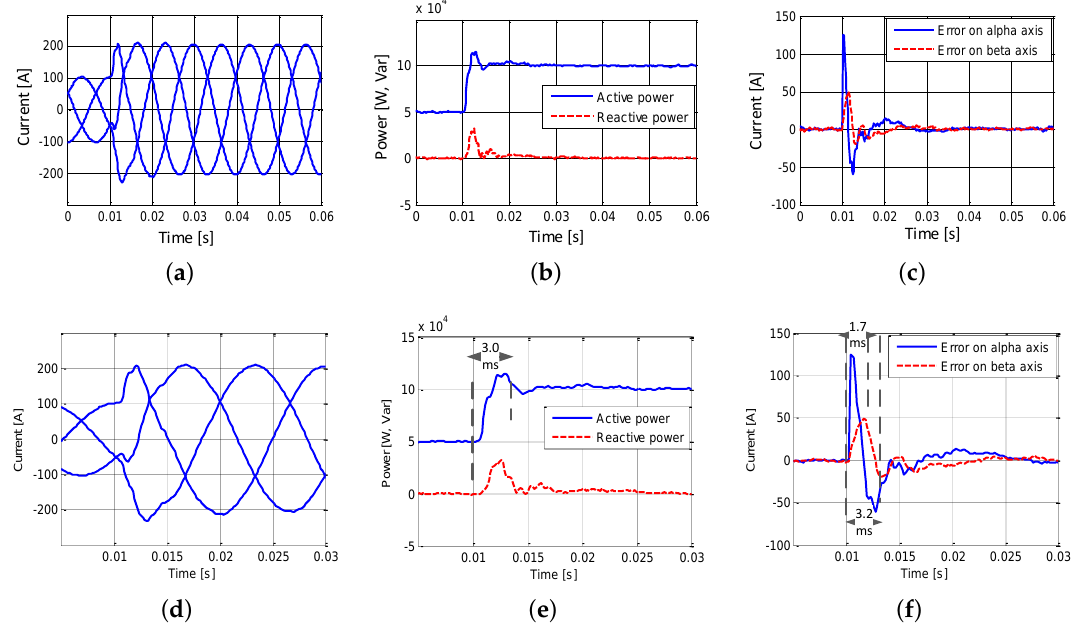
Figure 10. Simulated performance of the 100-kW system when active power reference jumps from 50 kW to 100 kW: ( a ) grid injected current; ( b ) instantaneous active and reactive power injection; ( c ) current control error on the α and β axis; ( d ) zoom-in view of ( a ); ( e ) zoom-in view of ( b ); and ( f ) zoom-in view of ( c